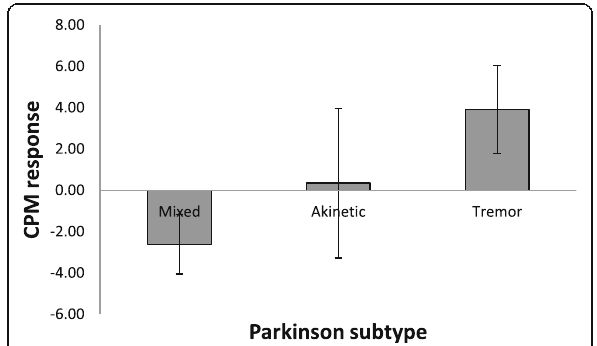
Fig. 3 Conditioned pain modulation magnitudes are shown for Parkinson subtypes. Means and standard error of means are presented. There were no significant subtype